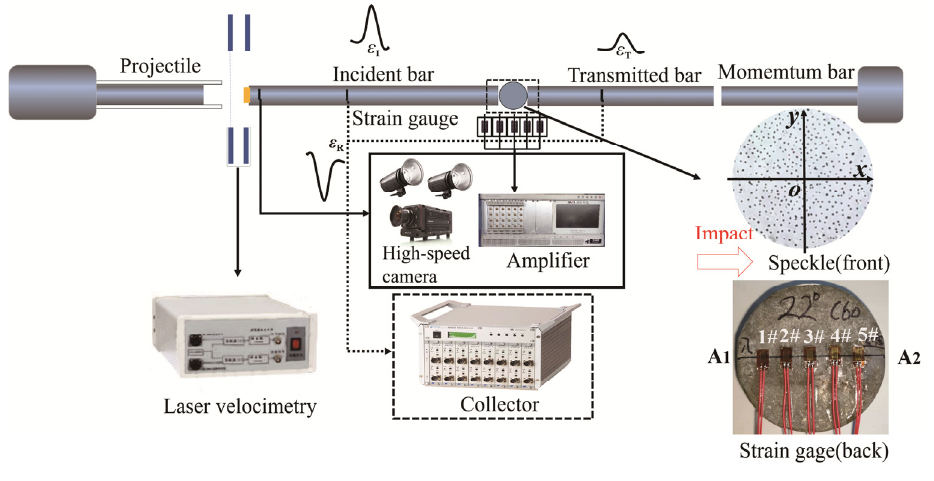
Figure 11. Schematic of the testing system. Table 3. The mix of self-compacting concrete (kg/m 3 ).